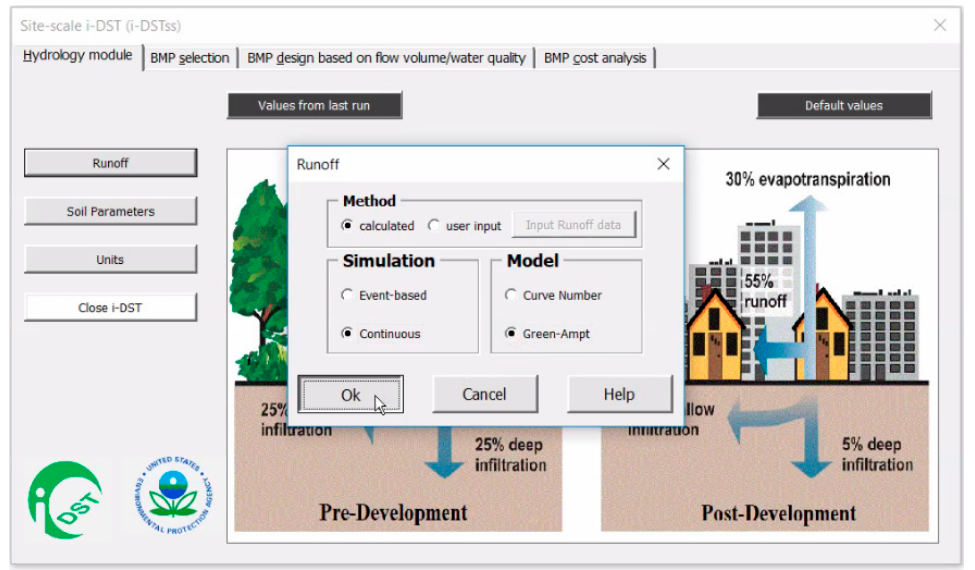
Figure A4. Hydrologic model Selection.